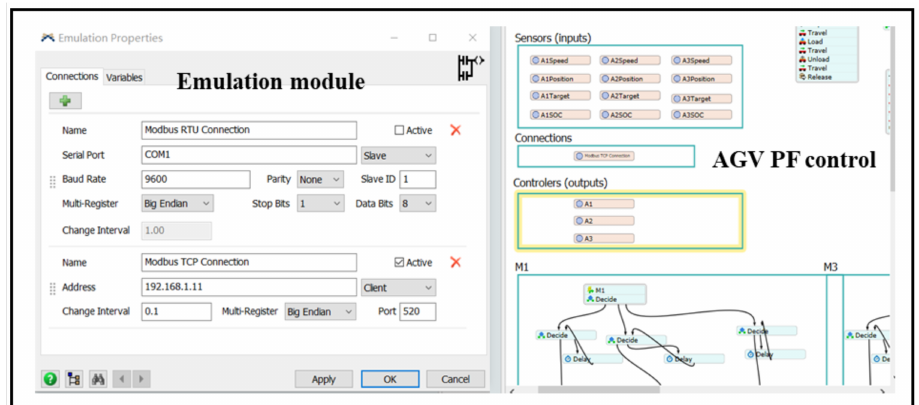
Figure 9. Emulation module and process flow configuration in